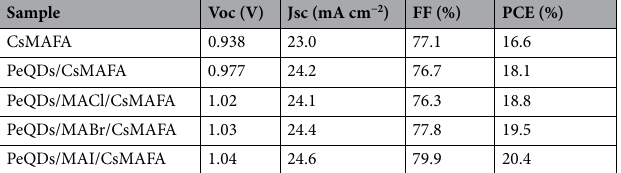
Table 2. Photovoltaic characteristics of the best-performing PeSCs based on the CsFAMA, PeQDs/CsFAMA, and PeQDs/MAX (Cl, Br, I)/CsFAMA.